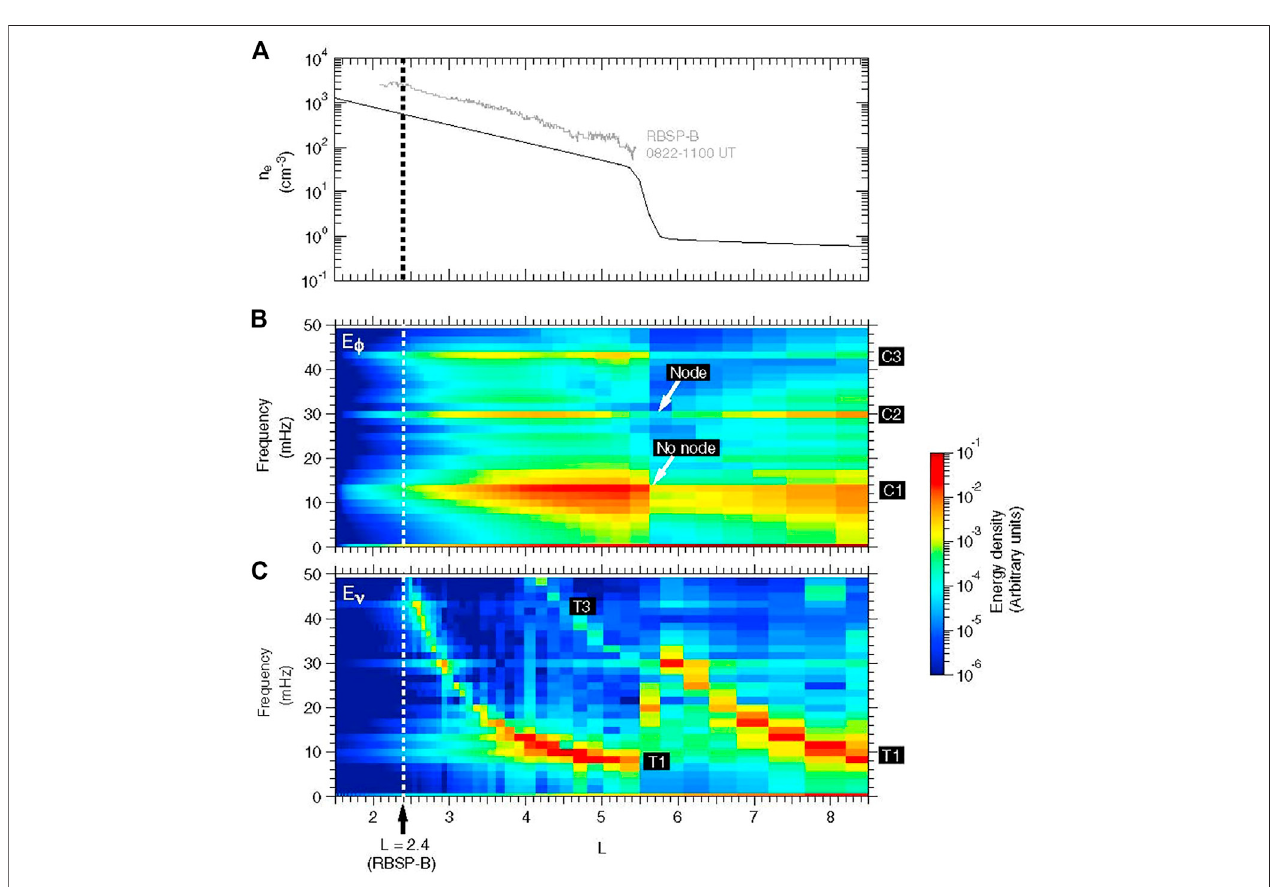
FIGURE 3 | (A) Density assumed in a model of cavity mode oscillations. Solid line gives the model pro fi le, and lighter line gives density determined from Van Allen Probeswavedata; (B) Spectralenergydensityfortheazimuthalcomponentoftheelectric fi eld(E φ ).ThreeharmonicsofthecavitymodeareindicatedbyC1,C2andC3; (C) Spectral energy density for the radial component of the electric fi eld (E ν ) showing fi eld line resonances. The fundamental mode is indicated by T1 and the third harmonic by T3 (Takahashi et al.,